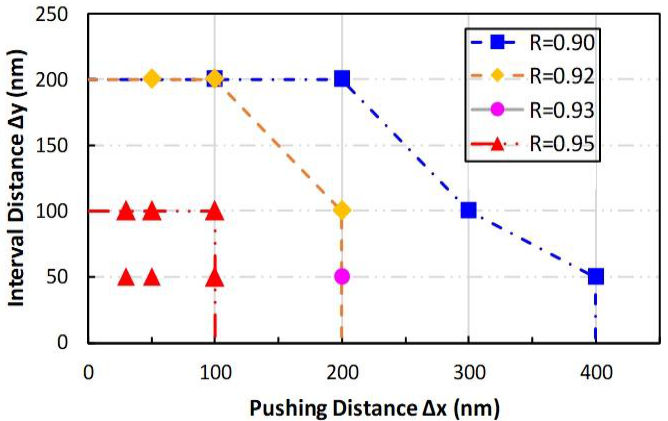
Figure 7. Pushing parameter region with higher length ratio value. The lines were obtained by connecting the same R -value combination points.